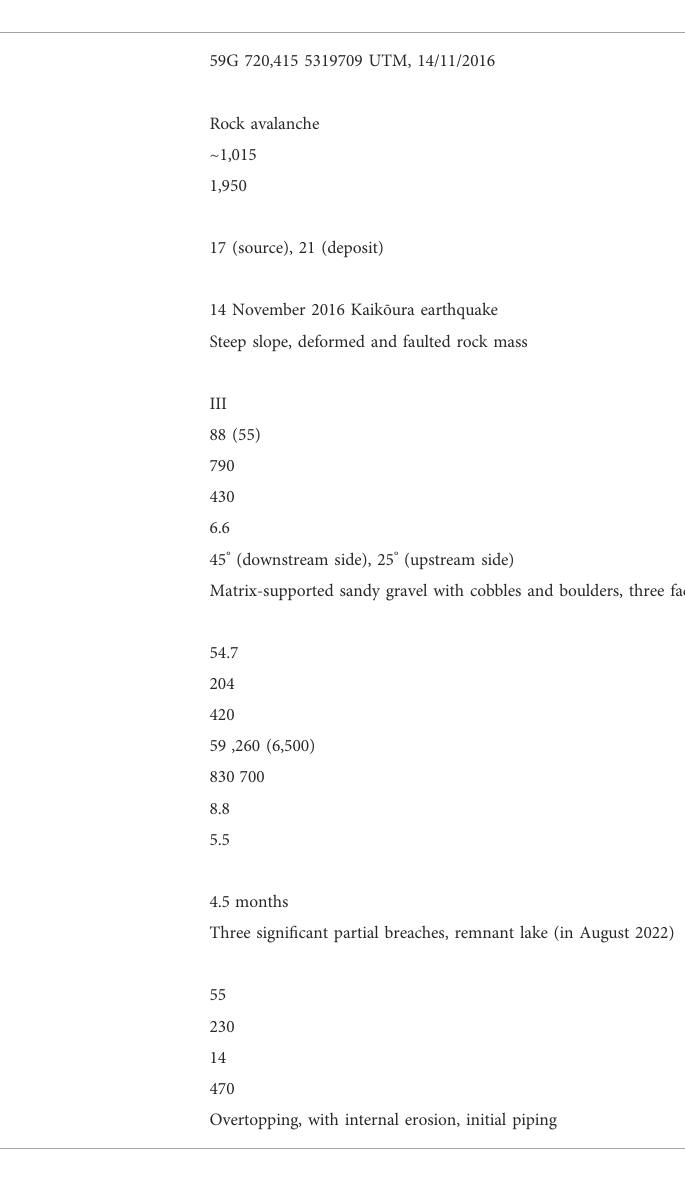
TABLE 5 Summary of the Hapuku Rock Avalanche, dam and